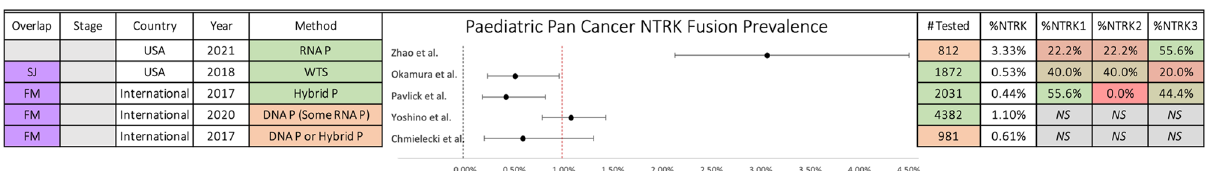
Figure 4. Summary of prevalence of NTRK fusions in paediatric pan-cancer studies. SJ Saint Jude Children’s Research Hospital, FM Foundation Medicine, USA United States of America, DNA/RNA/Hybrid P DNA/RNA/ Hybrid